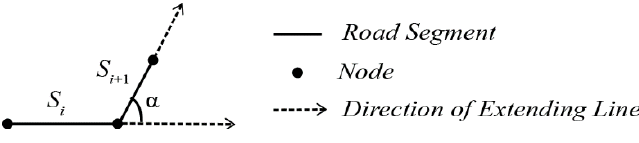
Figure 1. Calculation of road deflection angle.